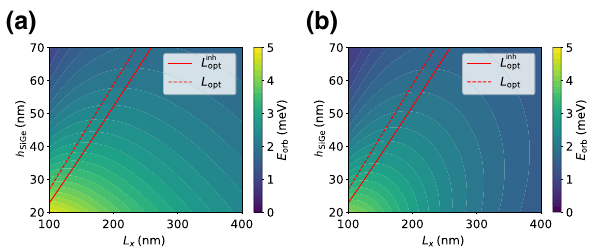
FIG. 16. Orbital splitting as a function of the geometric param- eters of the SQS without disorder. (a) Minimum orbital splitting extracted from the first mode of the Fourier analysis as a E x orb function of the SQS unit-cell length L x and the thickness of the SiGe layer ( h SiGe ). (b) Calculation of the minimum orbital from solving the Schrödinger equation on the full- splitting E x orb mode periodic potential. In both (a) and (b), h ox = 10 nm and V a = 100 mV is fixed and the red line indicates L inh dashed line L opt